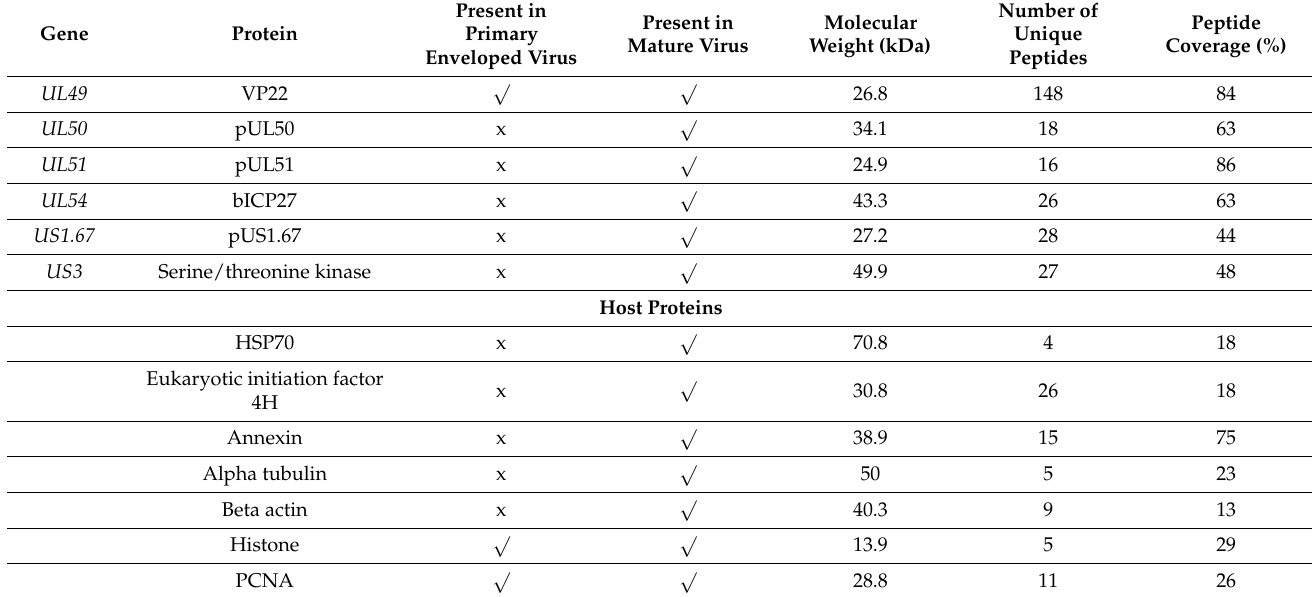
Indicates presence, and x indicates absence.